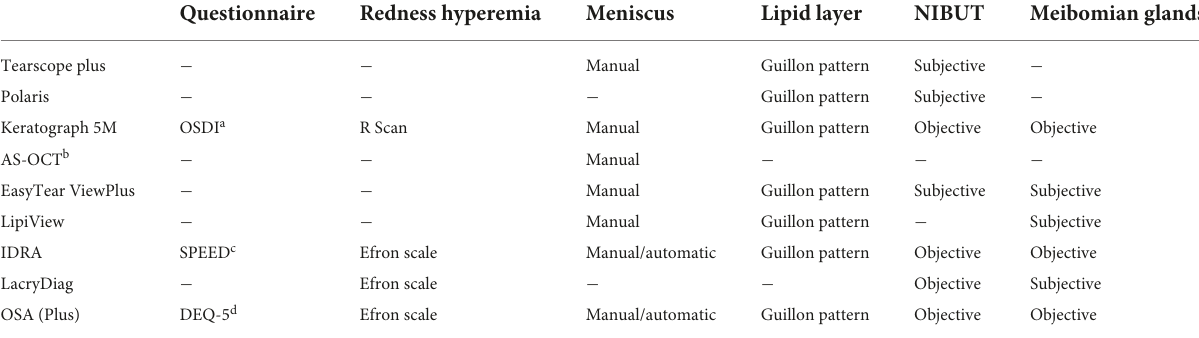
TABLE 1 Ocular surface diagnostics devices